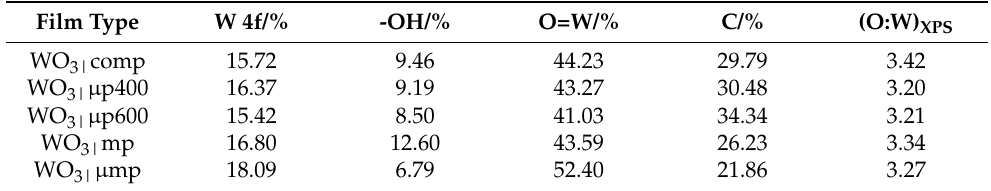
Table 3. Elemental composition of the different tungsten oxide thin films obtained from XPS, and the calculated (O:W) XPS ratios.